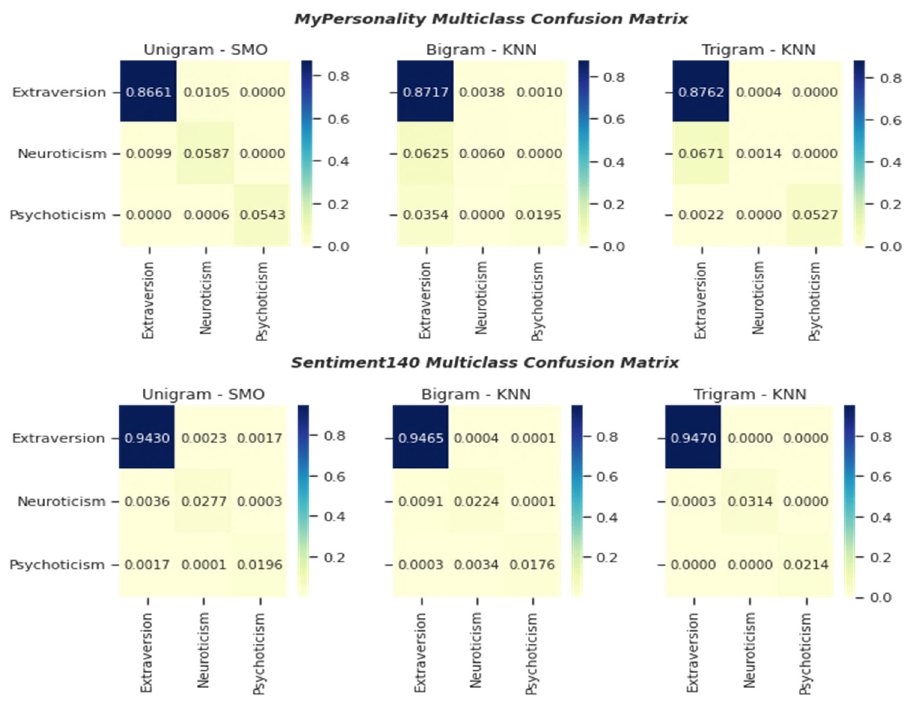
Figure 8. Confusion Matrix of Multiclass Classification.